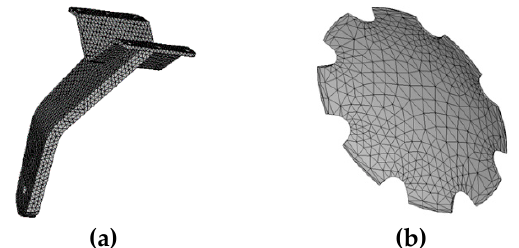
Figure 9. FE model of disk harrow assembly. ( a ) Disk harrow arm ( b ) Disk